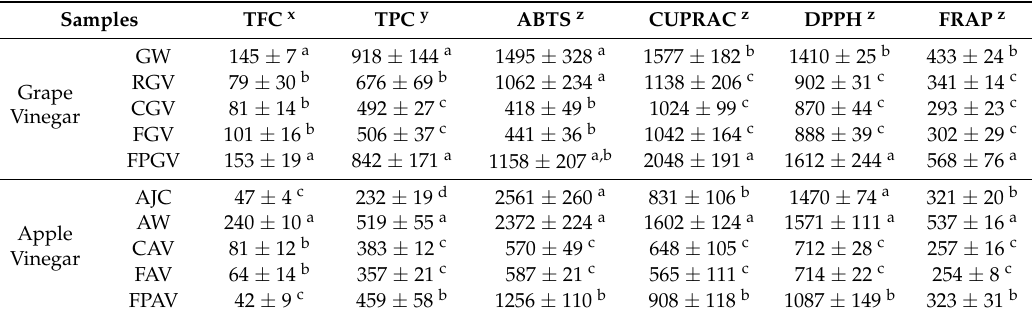
Table 2. Total flavonoid, phenolic content, and total antioxidant capacity of grape and apple vinegar processing